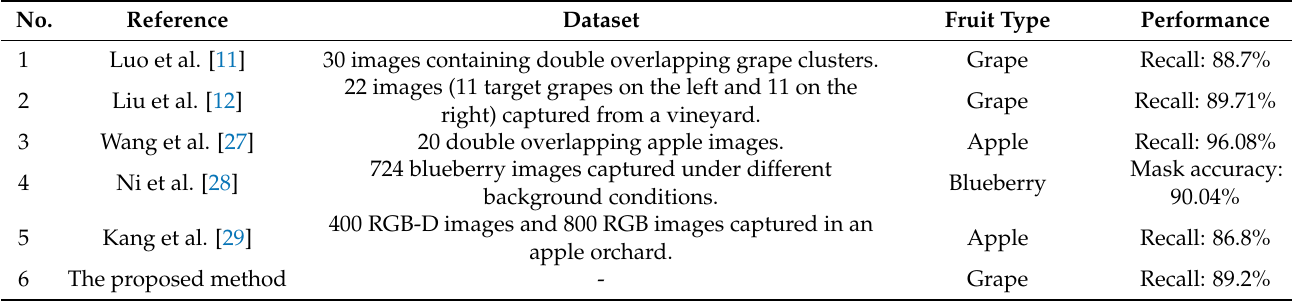
Table 3. Some other studies on fruit